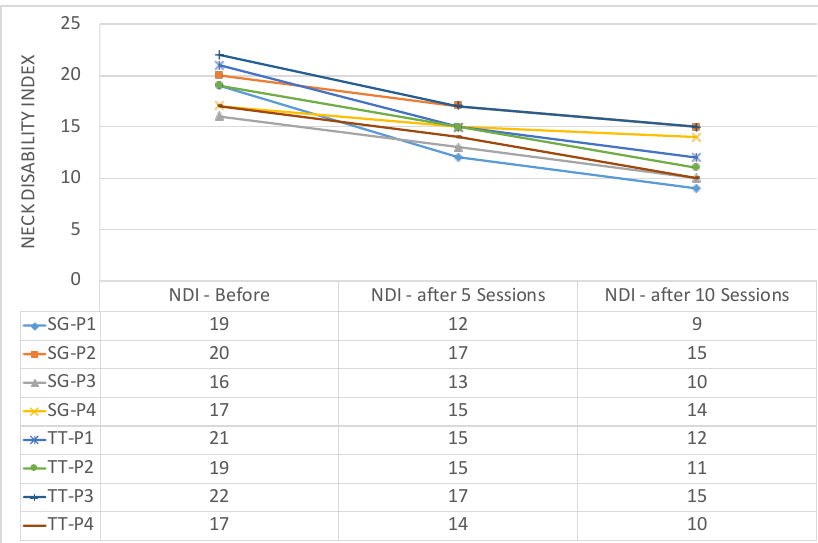
Figure 16. Evolution of Visual Analog Scale (VAS) score for patients using RehaBot vs. patients using traditional therapy.